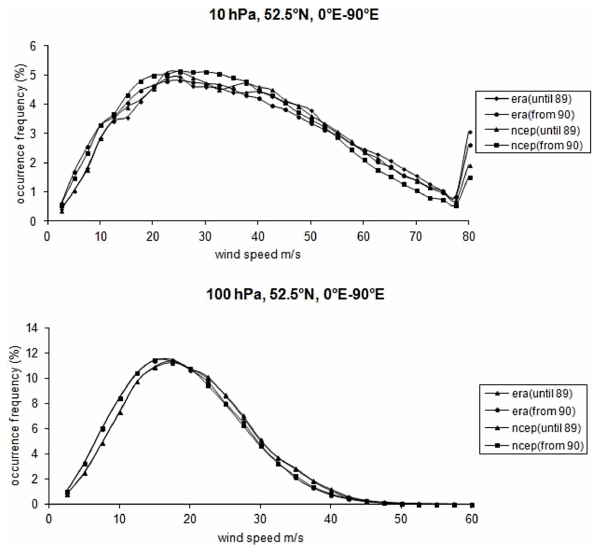
Fig. 1. Zonal wind speed average occurrence frequency for ERA- 40 and NCEP/NCAR reanalyses, 52.5 ◦ N, sector 0–90 ◦ E, 100hPa (top panel) and 10hPa (bottom panel) for two periods of 1958–1989 (until 1989) and 1990–2001 (from 1990), winter half of the year. The value for 80ms − 1 means the sum of wind speeds ≥ 80ms − 1 . ERA-40 and NCEP/NCAR curves are indistinguishably identical for 100hPa, both